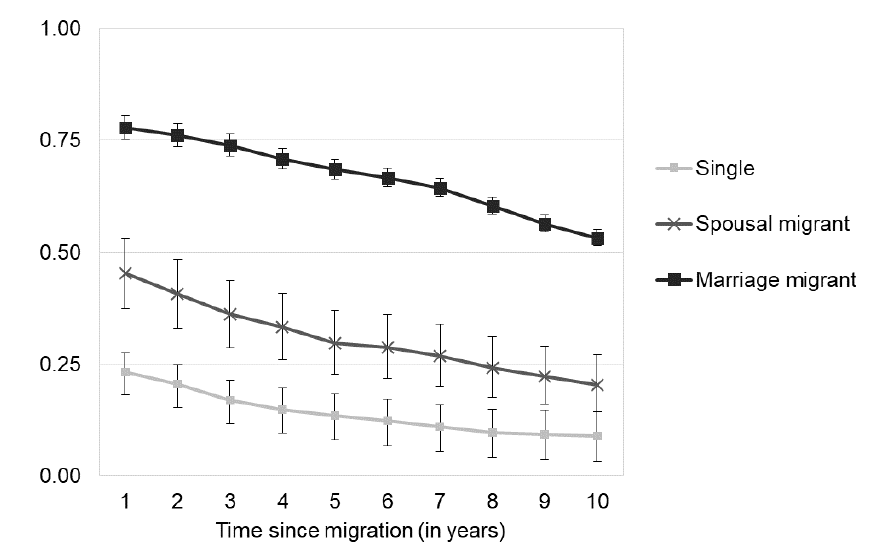
Figure 1 : Probability that the respondents had not yet entered the labour market